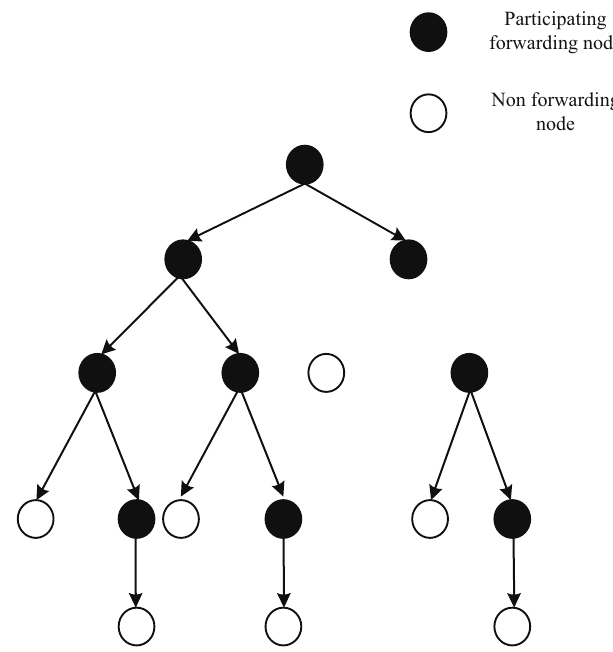
Figure 1: The information forwarding tree of social networks in college students ’ sports fi